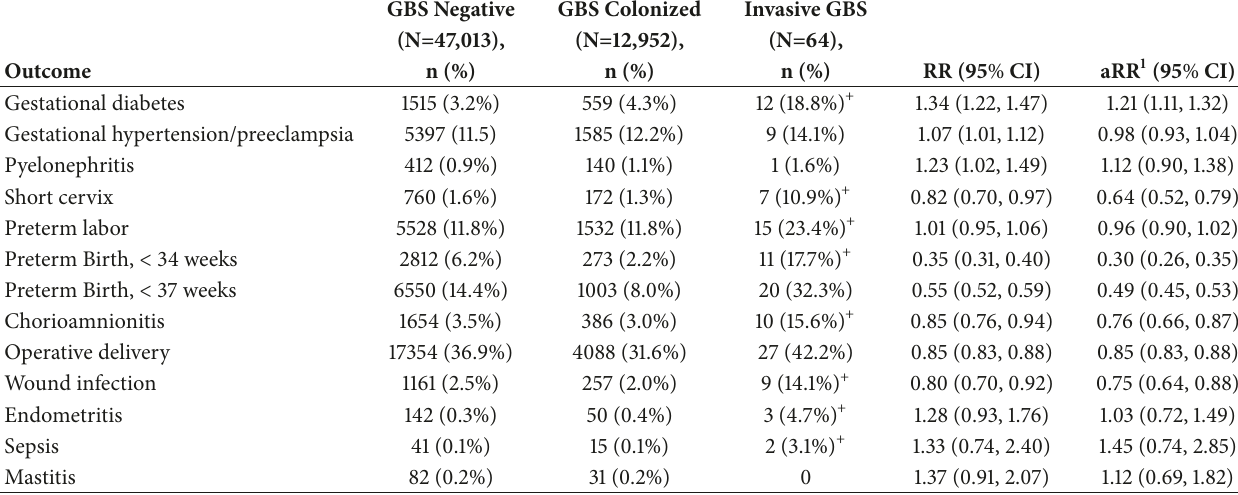
Table 3: Incidence and relative risk of adverse pregnancy outcomes by GBS colonization status.